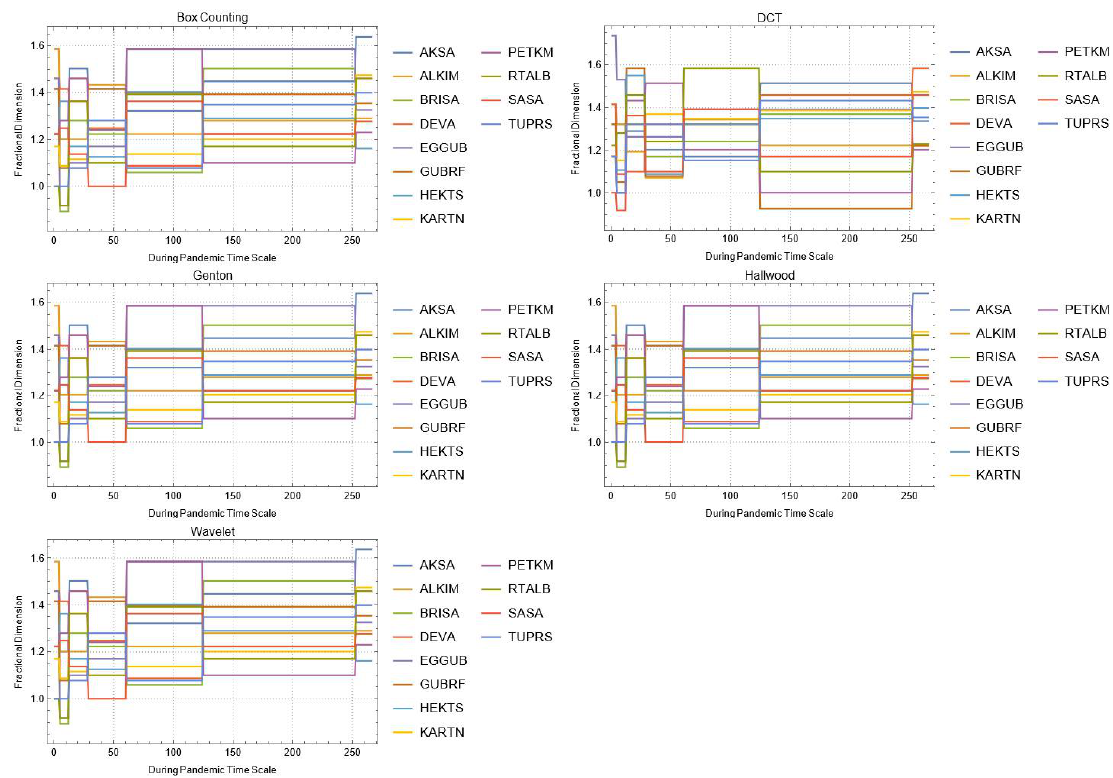
Figure A5. Daily changes of fractal dimensions during the pandemic (food, beverage and tobacco).